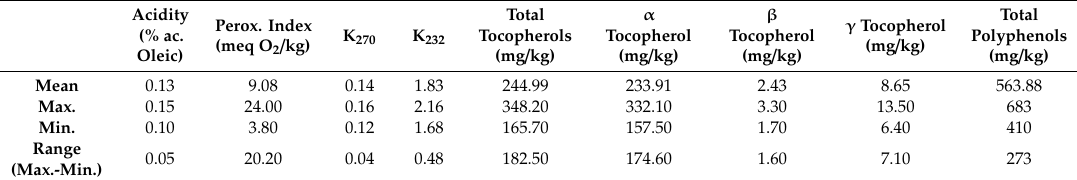
Table 5. Summary of the results of the chemical analyses of the 24 samples. Acidity (% ac.